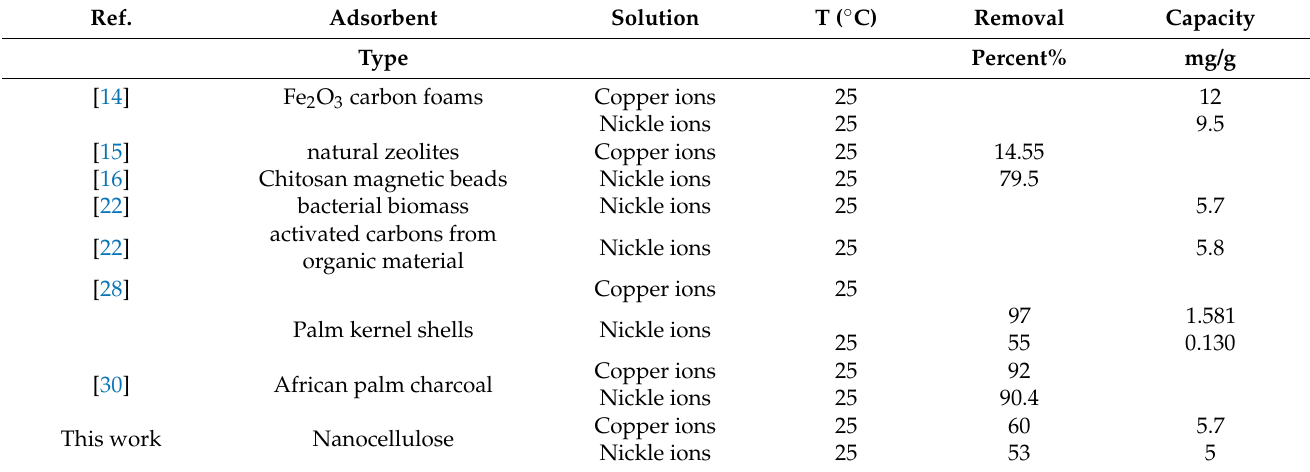
Table 3. A comparison of prepared nanocellulose with the other reported literature results.